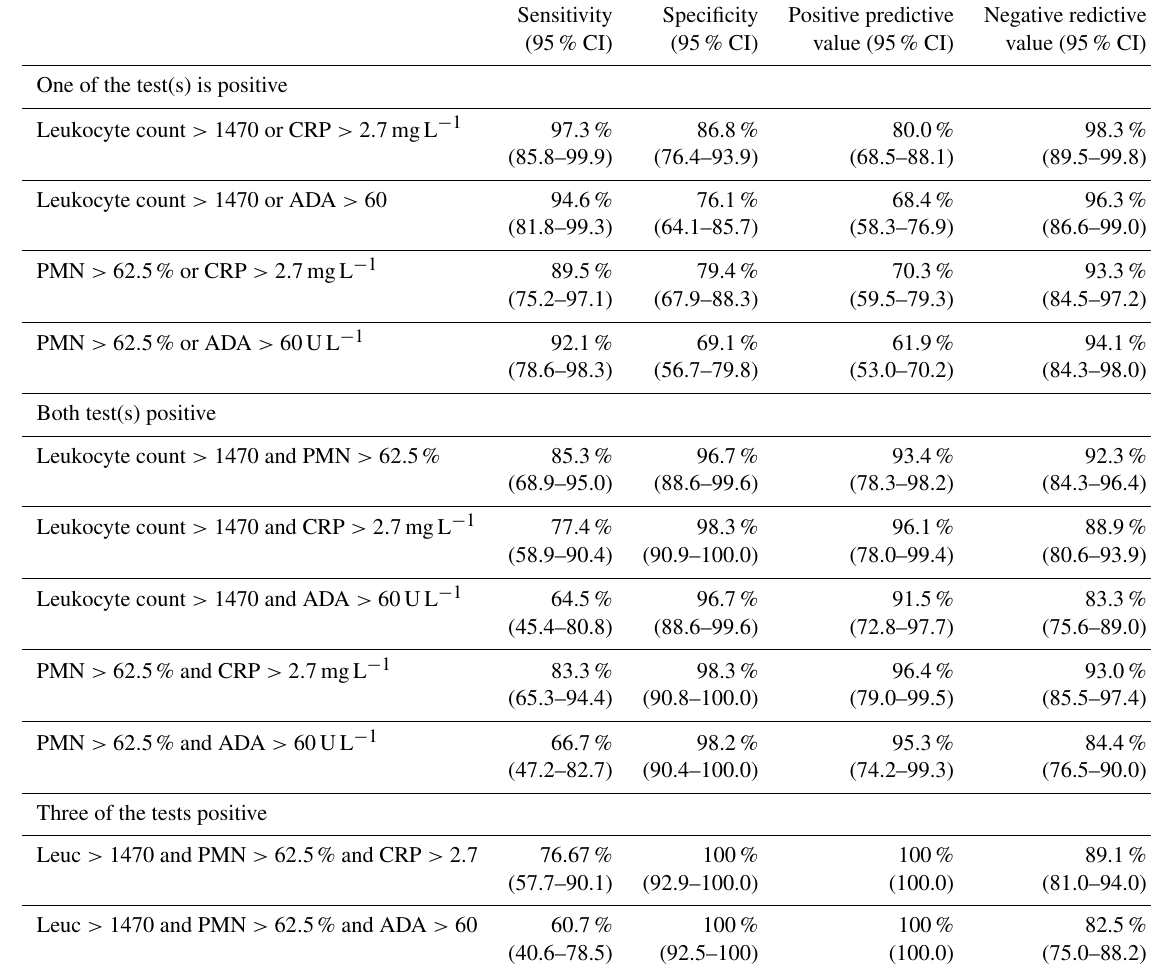
Table 4. Diagnostic accuracy of selected test(s) values and respective combinations.